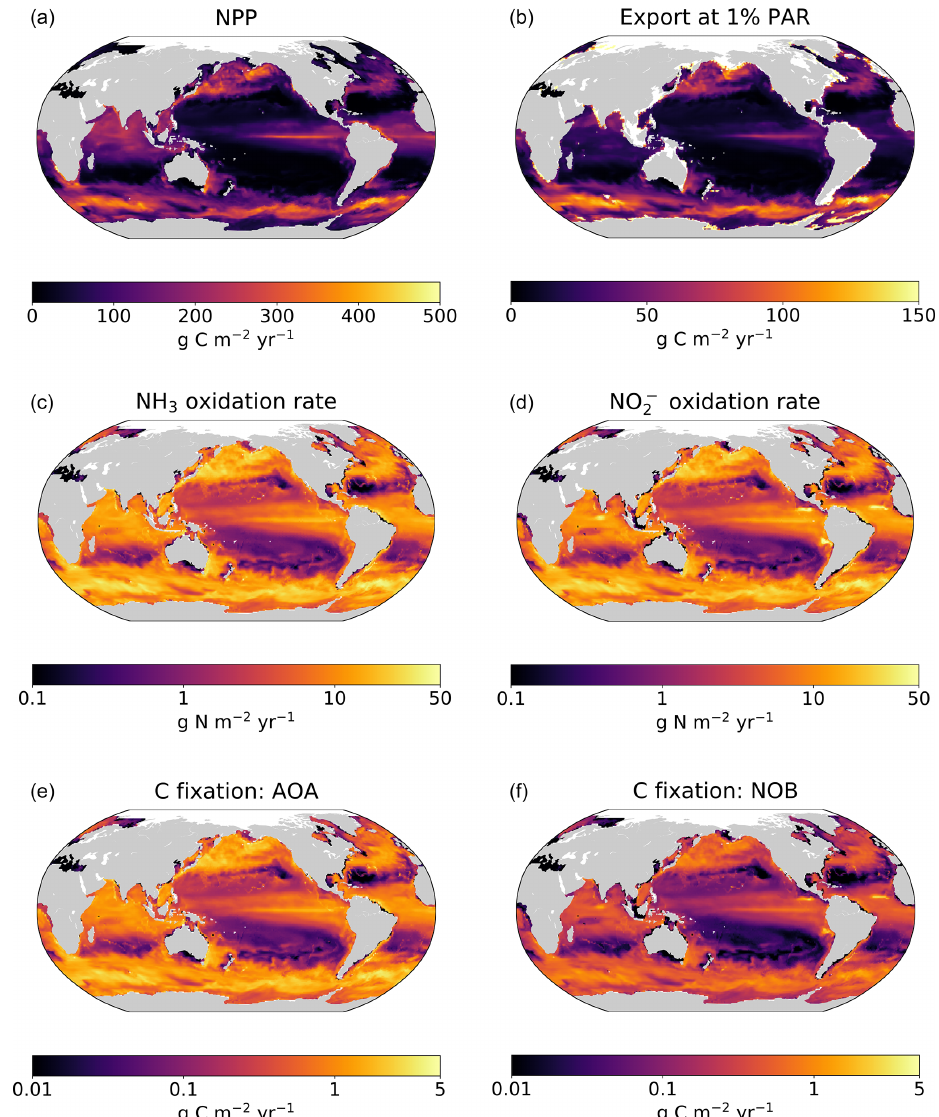
Figure 4. Output from the global ecosystem model (Darwin-MITgcm). (a) Net primary productivity (NPP). (b) Export of particulate organic carbon from the euphotic zone (calculated at the 1% light level). (c) Ammonia oxidation rate. (d) Nitrite oxidation rate. (e) Rate of carbon fixation associated with ammonia-oxidizing archaea (AOA). (d) Rate of carbon fixation associated with nitrite-oxidizing bacteria (NOB). All panels depict annual averages after 250 years of integration. Panels (a) and (c–f) depict vertically integrated